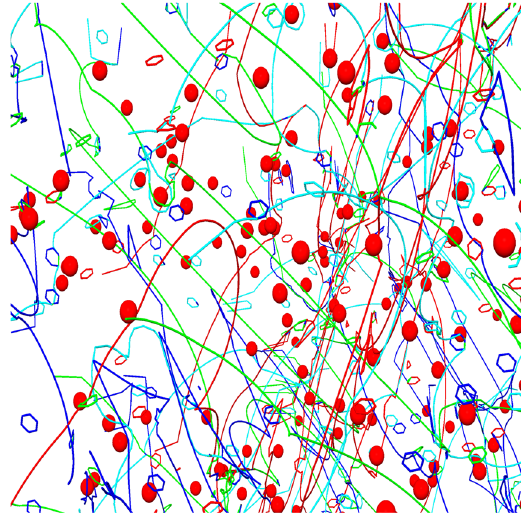
Figure 7. Close-up view of the 3D structure of a dislocation system with glissile dislocation loops and strong precipitates at a strain of ε = 0.74%. Different Burgers vectors are indicated with different colors as follows: dark blue = 〈 complex network where they pin to each other. Overcoming the precipitates (red spheres) has left Orowan loops around some of the obstacles. Both loops and precipitates act as obstacles for dislocation motion. Precipitate size parameter is R p = 5 nm and the loop radius is r l = 5 nm.